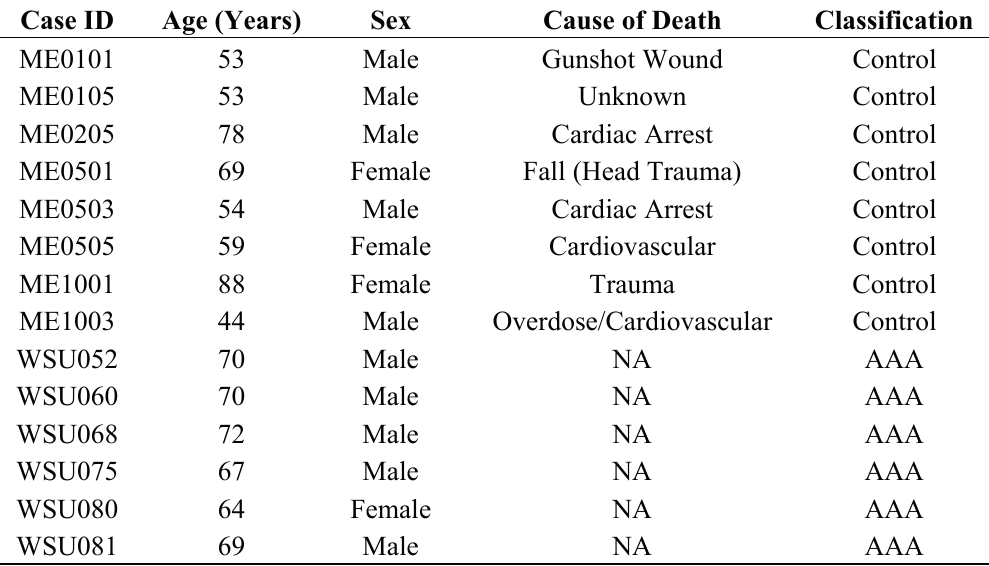
Table 1. Aortic tissue samples used for immunohistochemical